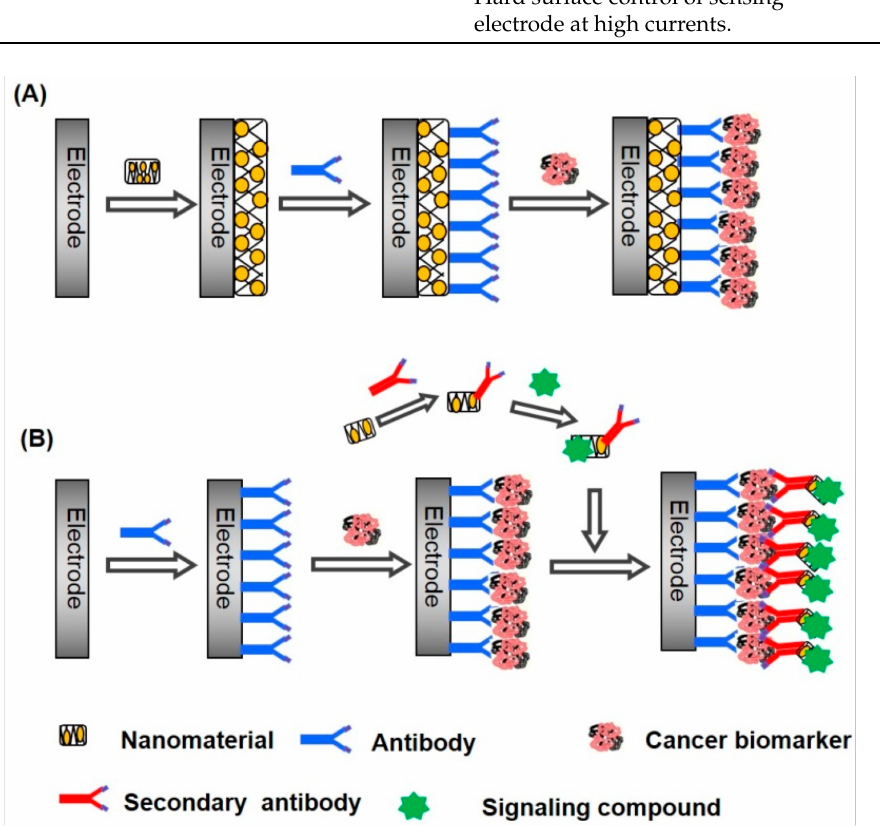
Figure 5. Employing nanomaterials for surface functionalization ( A ) with a signaling label ( B ) in constructing electrochemical biosensors for cancer biomarkers